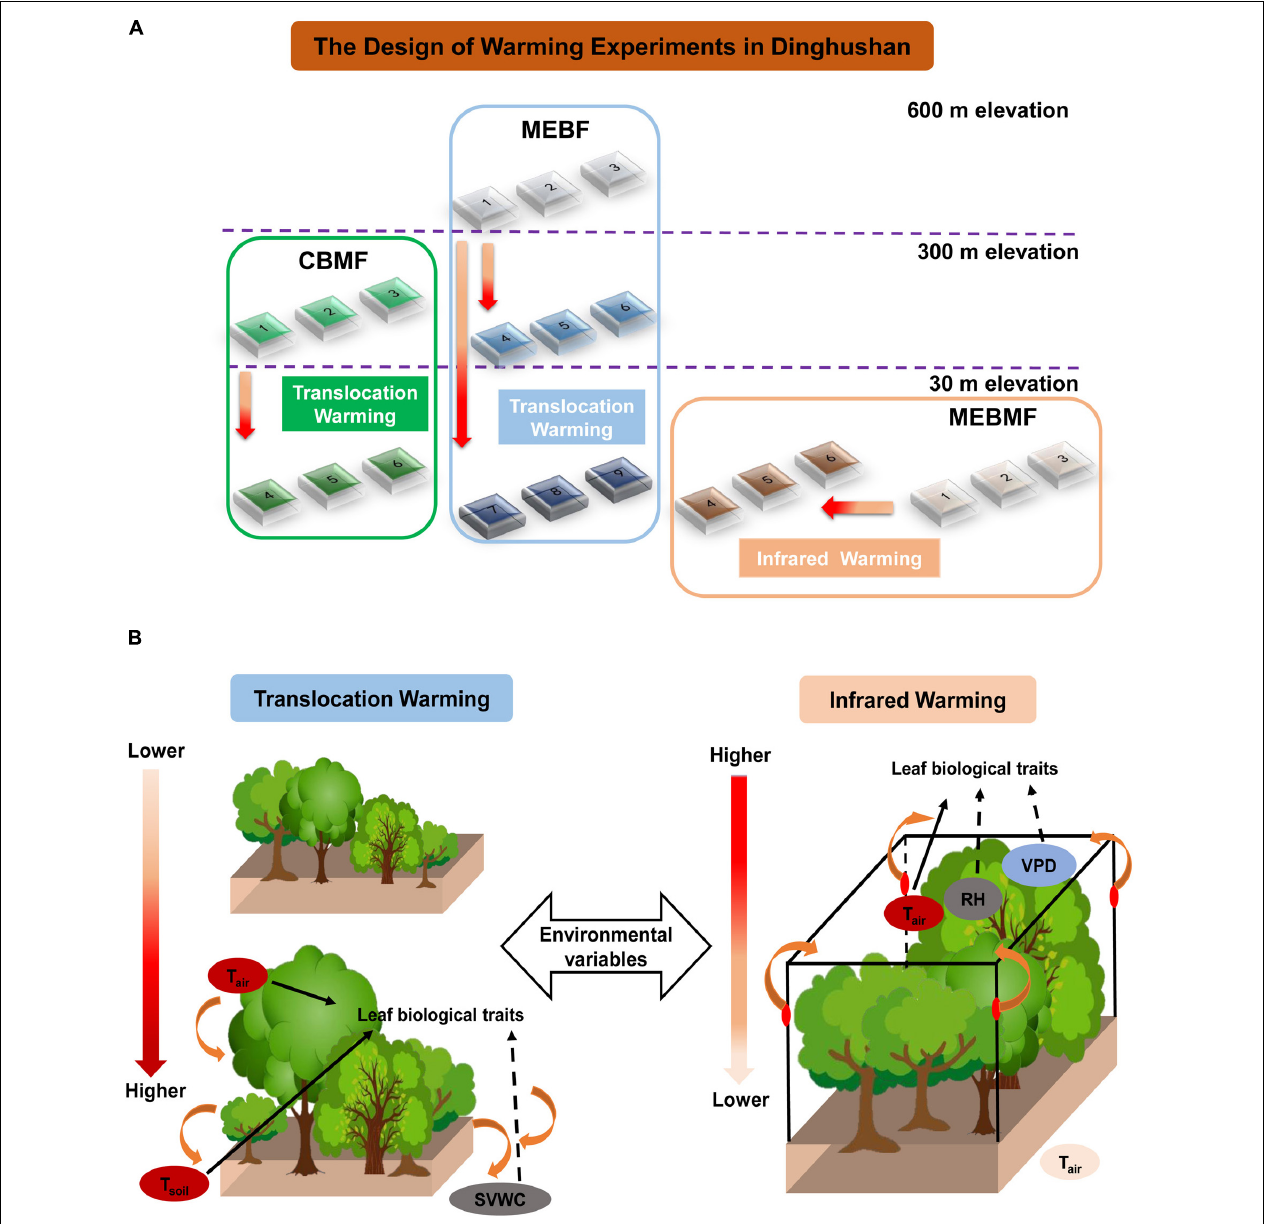
FIGURE 1 | (A) Schematic of the long-term filed warming experiments in Dinghushan, China: higher temperatures for coniferous and broadleaf mixed forest (CBMF) and mountain evergreen broadleaf forest (MEBF) were achieved by translocation warming; while higher temperatures for monsoon evergreen broadleaf forest (MEBMF) was achieved by infrared (IR) warming. (B) the conceptual diagram for the effects of environmental variables caused by translocation and infrared warming on biological traits. Tranloscation warming increased T air and T soil but decreased SVWC; IR warming enhanced T air and VPD but reduced